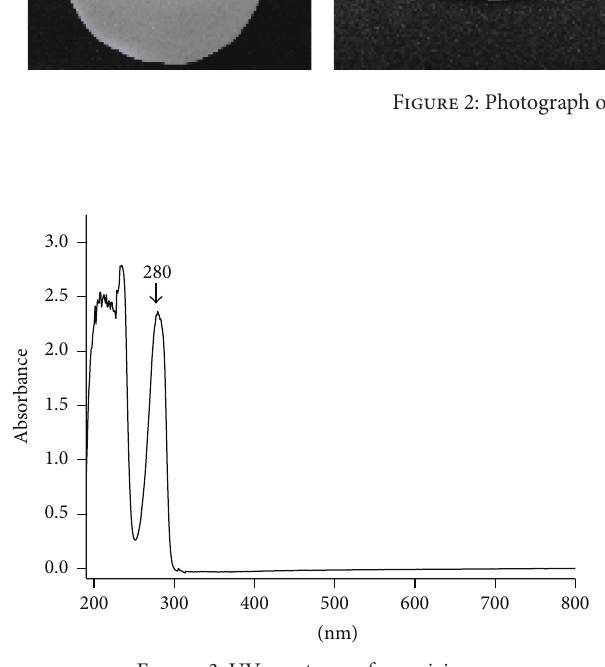
Figure 3: UV spectrum of capsaicin.